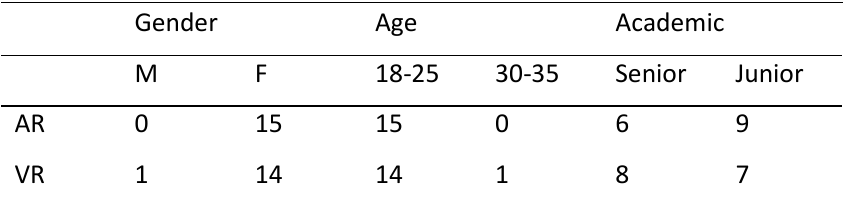
Figure 4. Floor plan of the office